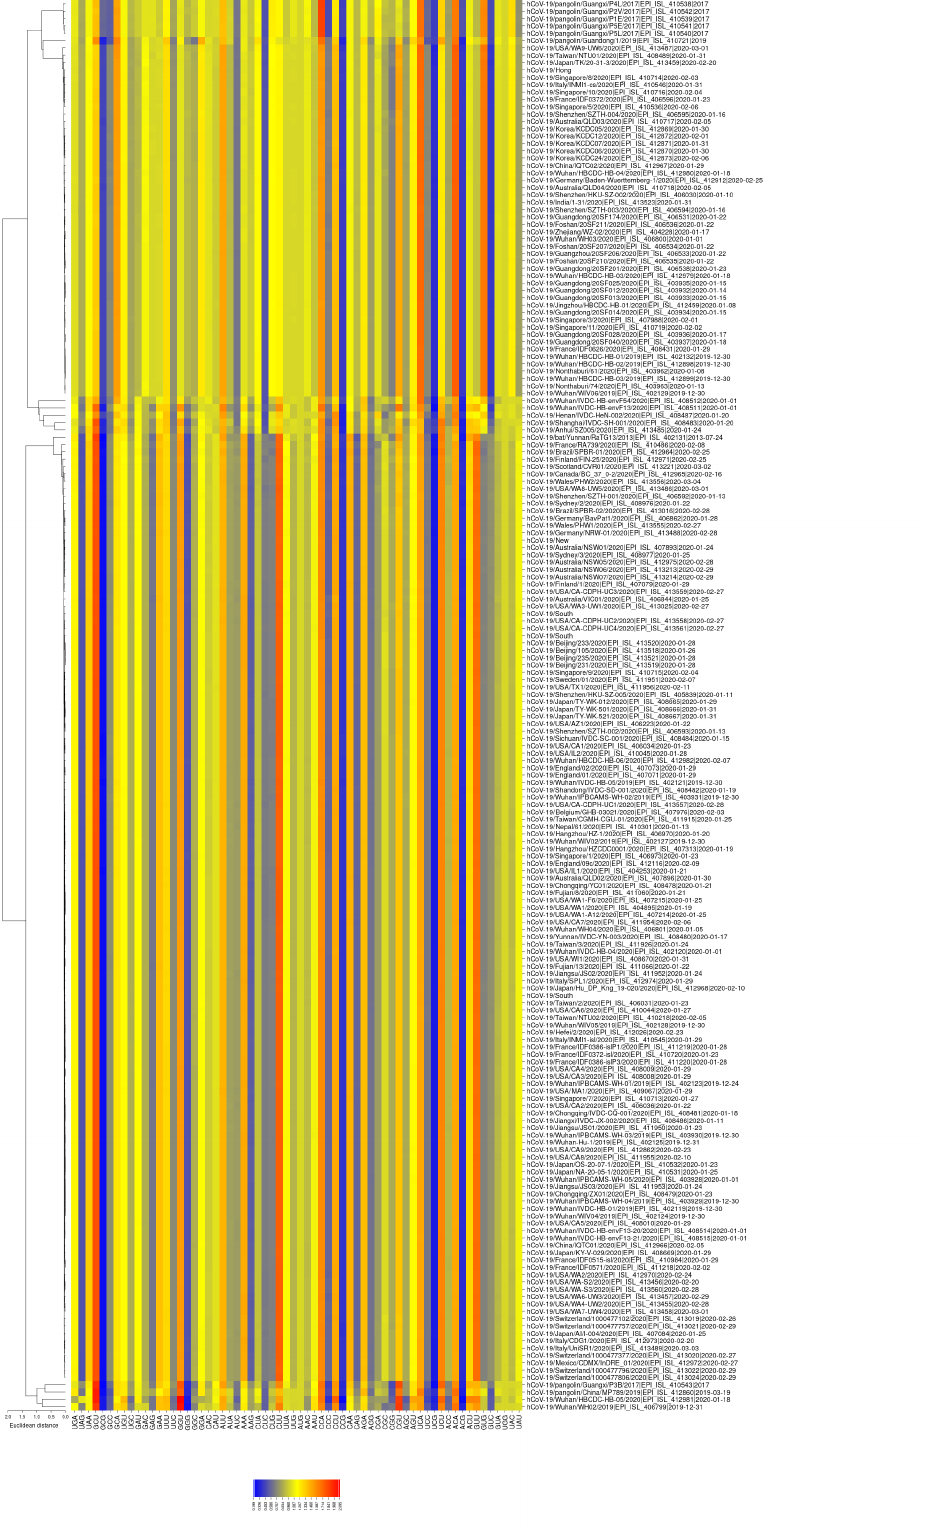
Figure A2. RSCU vectors of coronavirus. Patterns of RSCU vectors for 306 patients with SARS-CoV-2 from different countries (data downloaded from